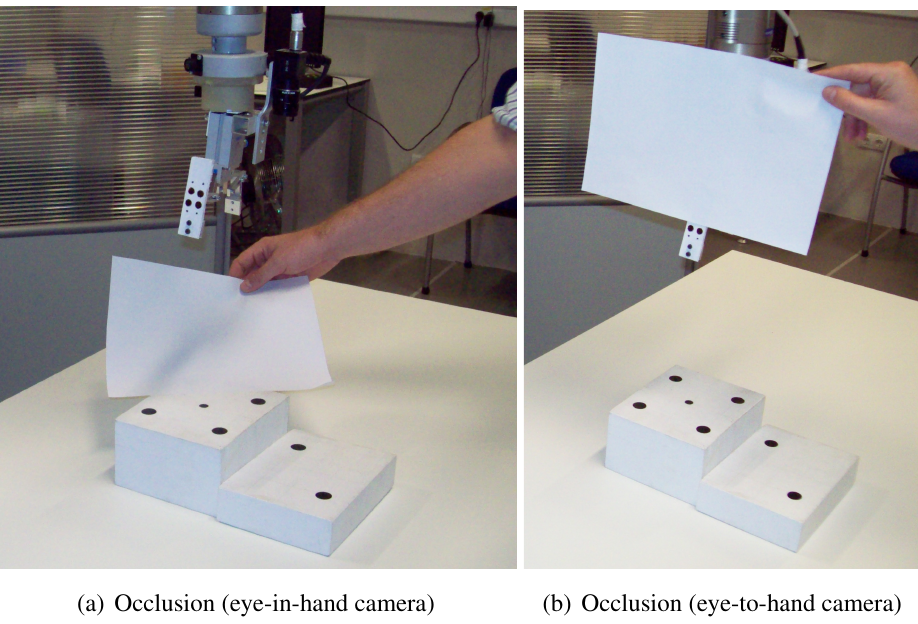
Figure 14. Images of the errors which are produced deliberately by the occlusion of features during the control